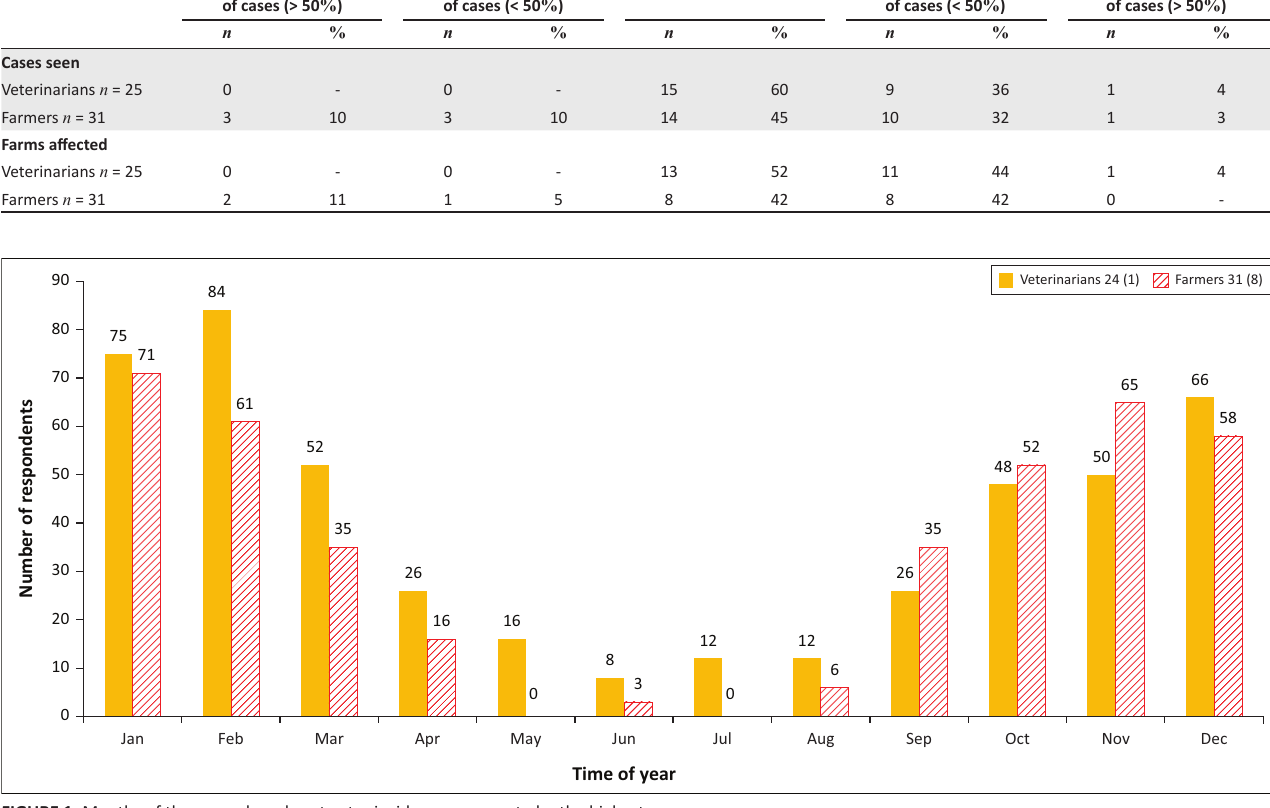
TABLE 2: Changes observed in the number of cases seen and farms affected. Category